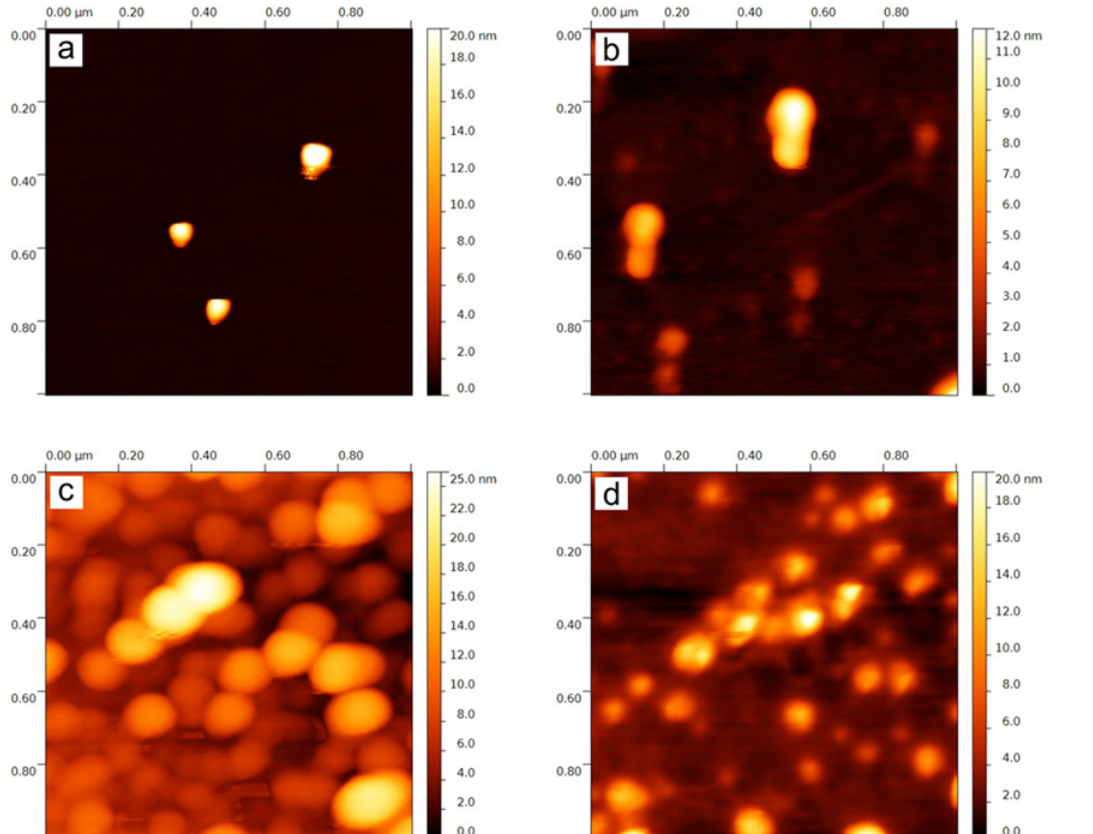
Fig 1. AFM images of AgBr nanoparticles prepared in the presence of a) PEG, b) PVP, c) PVA and d) HEC.